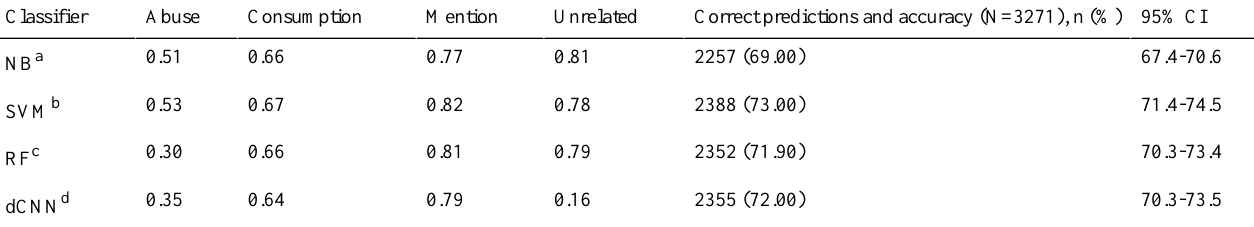
Table 3. Class-specific F1 scores, overall accuracy, and 95% CIs for the accuracy for 4 classifiers.